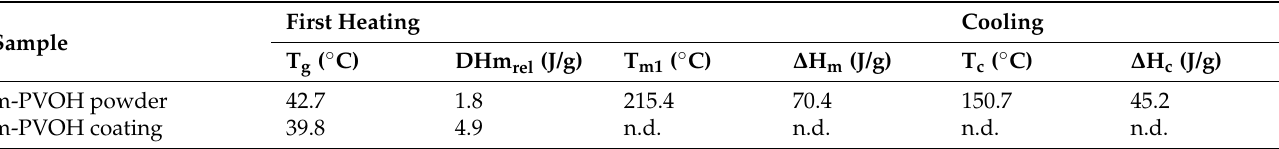
Figure 4. DSC first heating thermogram of m-PVOH powder and m-PVOH thin-coating layer. Table 2. Thermal parameters of the m-PVOH powder and m-PVOH thin-coating layer related to the first heating and cooling